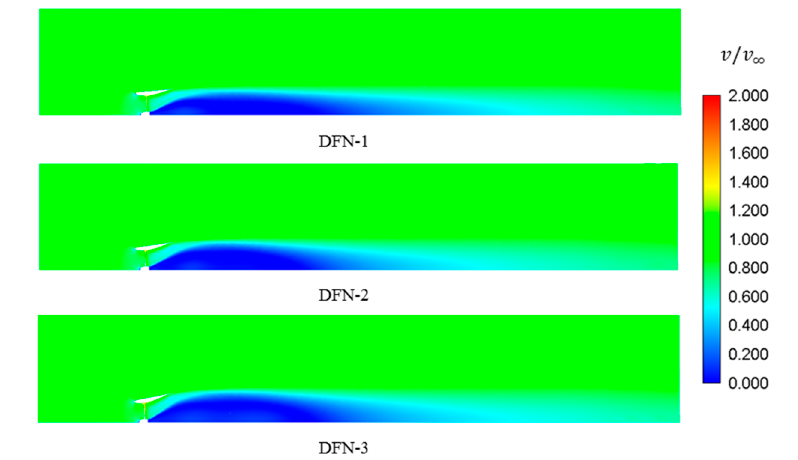
Figure 15. Normalized velocity in longitudinal plane at TSR = 5, turbine design DFN.